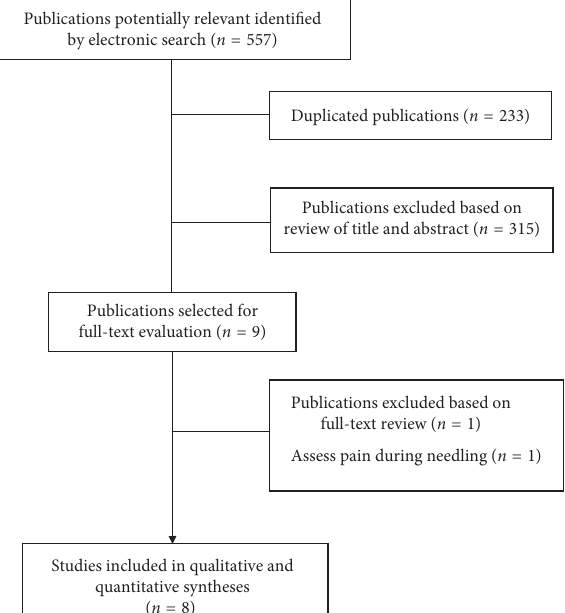
Figure 1: Preferred Reporting Items for Systematic Reviews and Meta-Analyses (PRISMA) Flow